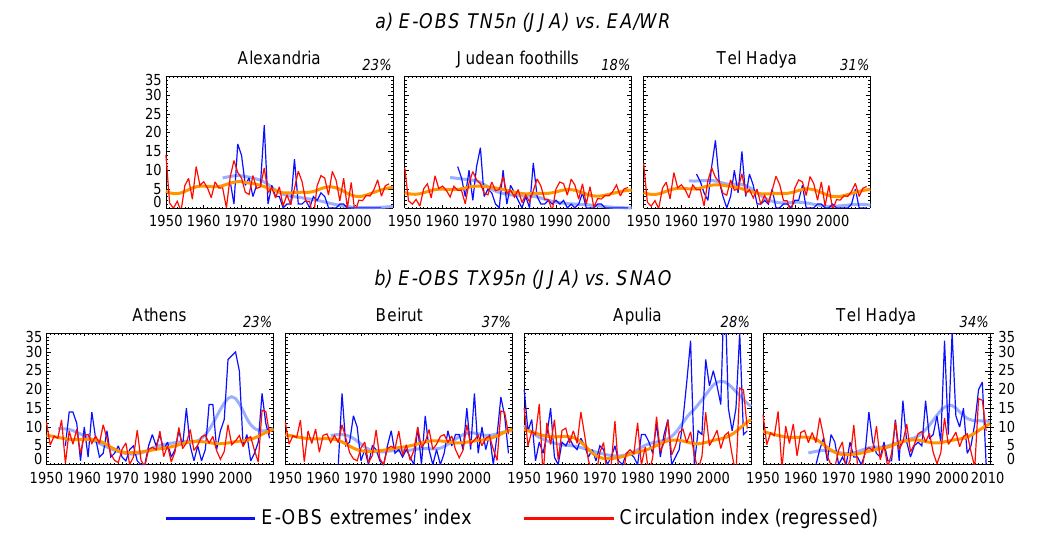
Fig. 7. Observed (blue) indices of temperature extremes against reconstructed values (red), as in Fig. 6, but for summer (JJA): (a) TN5n vs. EA/WR, (b) TX95n vs. SNAO.